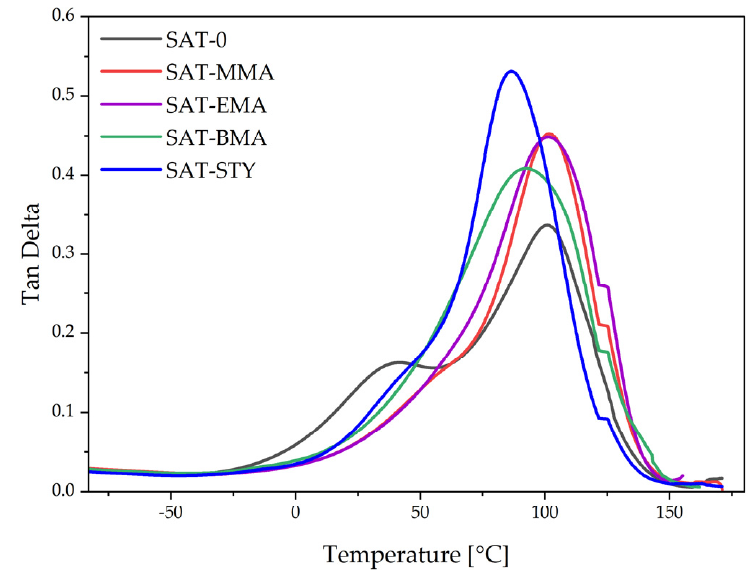
Figure 11. Tangens delta (tan δ ) of thermally cured SATs.